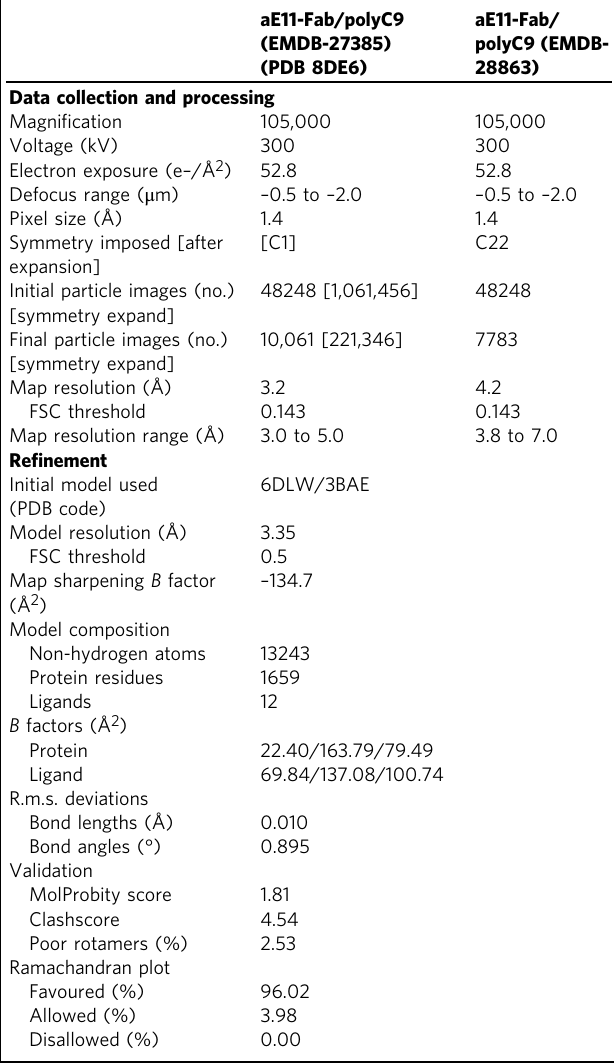
Table 1 Cryo-EM data collection, re fi nement, and validation